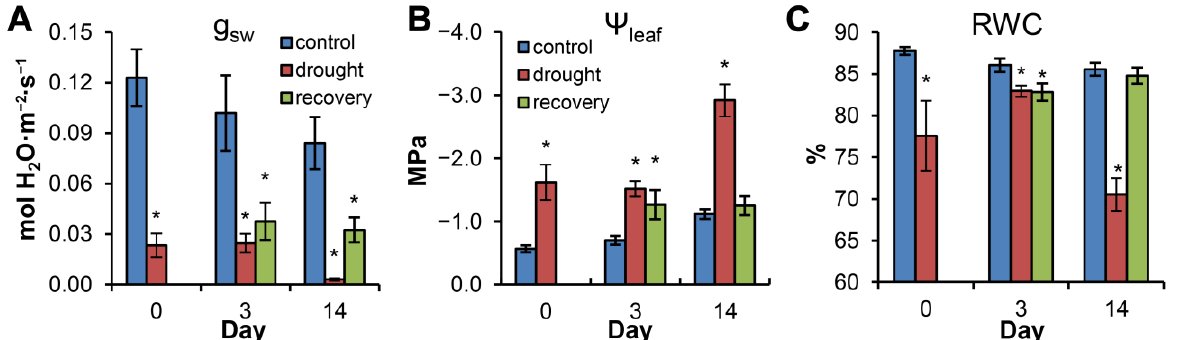
Figure 2. Effects of water stress on stomatal conductance ( A ), leaf water potential ( B ) and RWC ( C ) in the needles of plants in Experiment 1. The experimental data are adapted from Zlobin et al. [14]. Pairwise comparisons of the means were performed between control and drought-stressed and control and recovering plants at each separate time point using Student’s t- test or Mann–Whitney rank sum test. Asterisks (*) denote significant differences at p < 0.05 between the control and experimental variants at each time point.